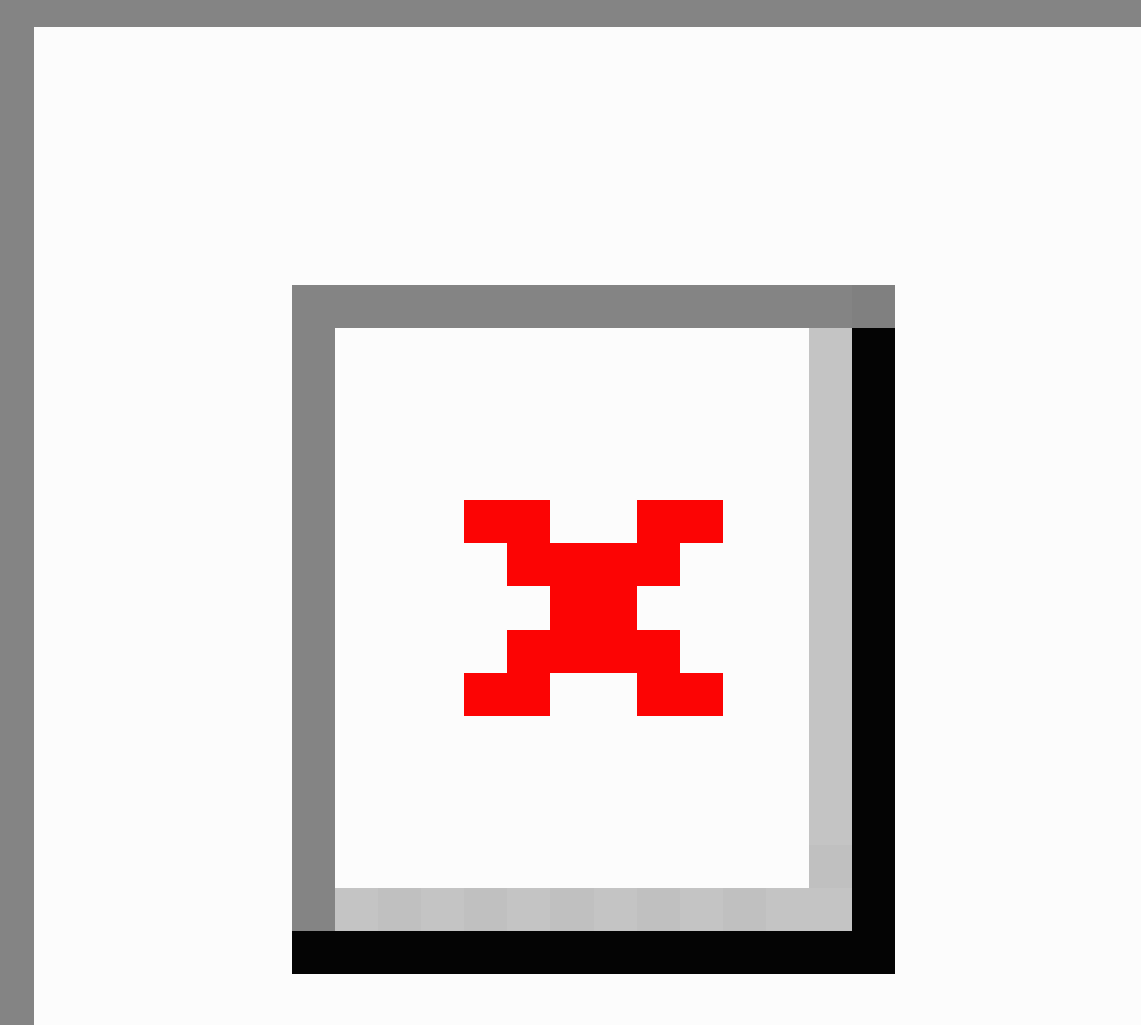
Figure 4. Research variables were combined in clusters and, after obtaining the square Euclidean distance and plotting on a dendrogram, the keys indicated the similarity between the variables evaluated in the survey. The central line indicates an adjustment by the square